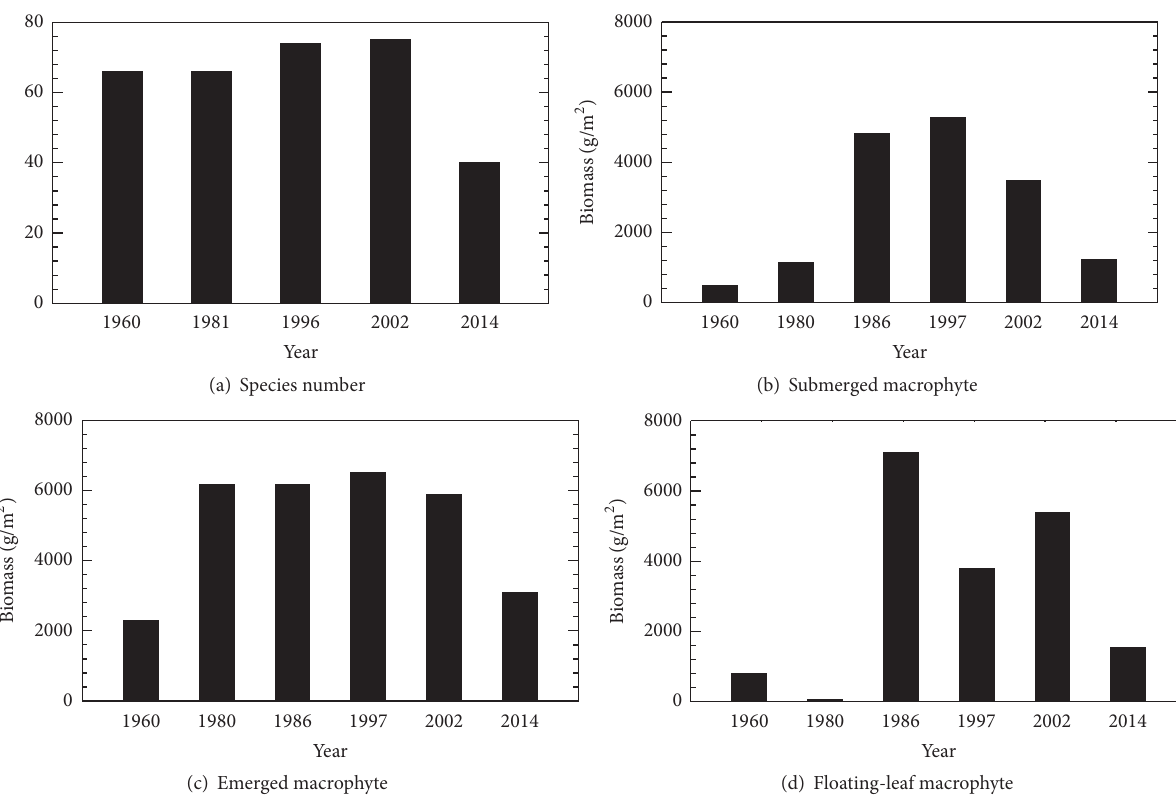
Figure 6: Species number (a), submerged macrophytes biomass (b), emerged macrophytes biomass (c), and floating-leaf macrophytes biomass (d) in east Taihu Lake from 1960 to